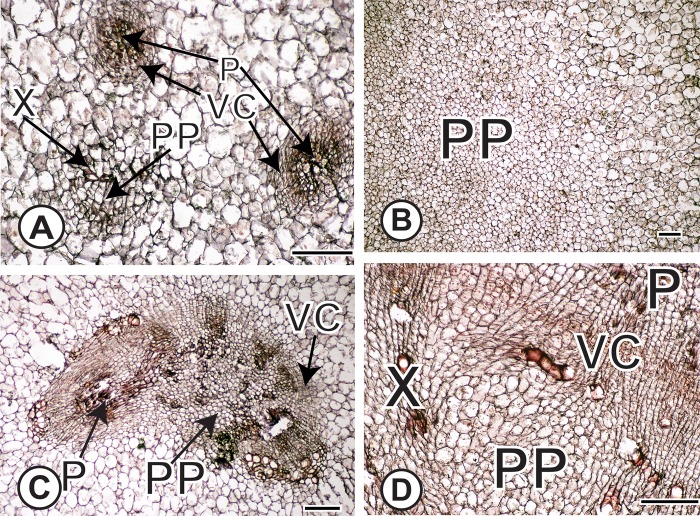
Anatomical evidence of proliferation of parenchyma (PP).(A) PP within a VB in turnip in which proliferative cells are surrounded by scattered vessel elements. Two mature vascular bundles are labeled as well. (B) PP in center of kohlrabi stem. Note the profusion of smaller proliferative cells next to the larger, mature parenchyma cells. (C) PP has disrupted the patterning of a SVB. Note the fragments of phloem (darker staining) near the lighter-staining, small proliferative cells. (D) Intrusive proliferation of parenchyma near the main vascular cambium results in distorted cells and disrupted vessel elements. Note the sheared parenchyma cells next to the red-stained vessel elements that are no longer longitudinally oriented. From circled region in Fig 3F. Scale bars: 100μm. X = xylem; P = phloem; PP = proliferation of parenchyma; VC = vascular cambium.